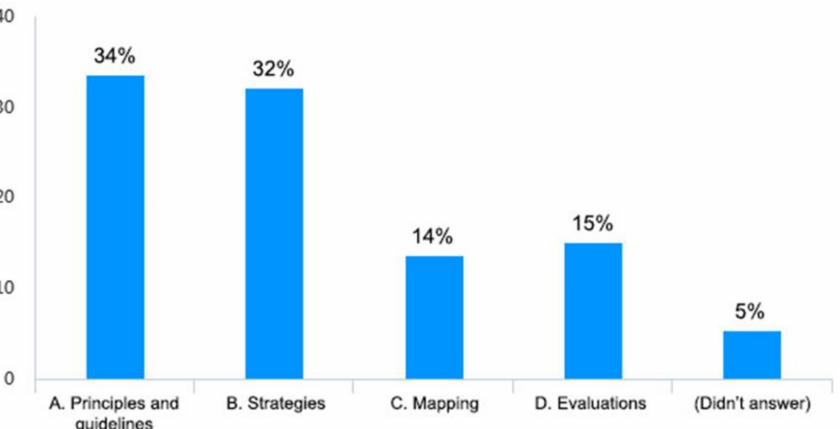
Figure 6. Question 5. The most commonly used microclimatic design method (respondents not understand the four